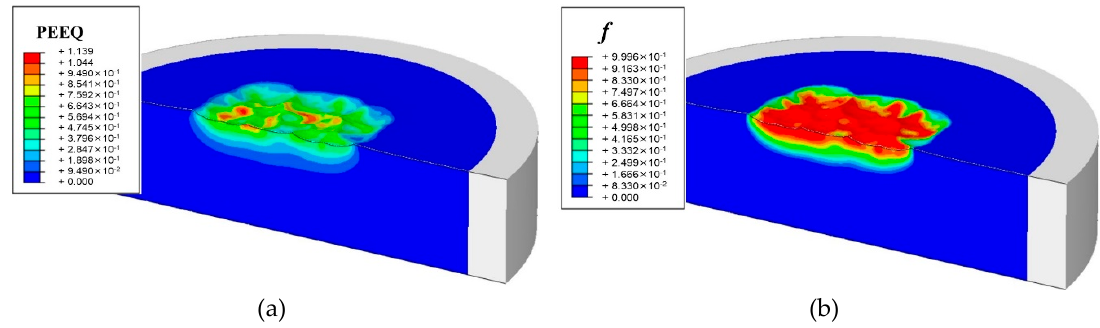
Figure 10. Distributions of ( a ) equivalent plastic strain, PEEQ; ( b ) the martensitic volume fraction, f.